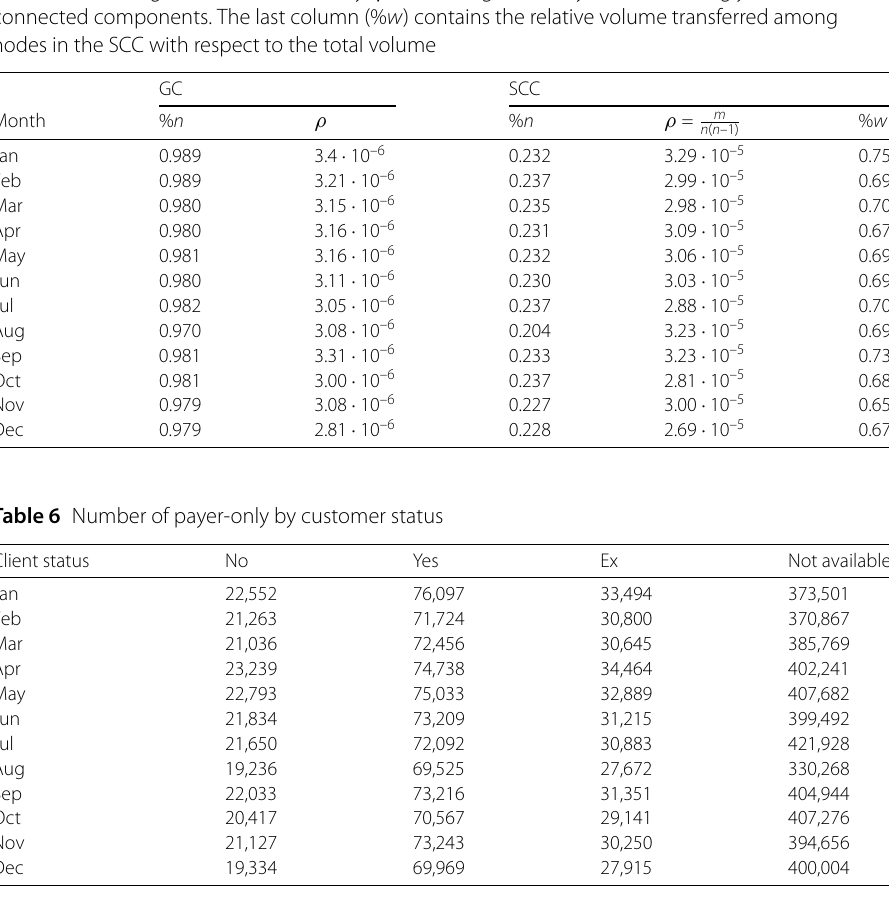
Table 5 Percentage size (% n ) and density ( ρ ) of the largest weakly (GC) and strongly (SCC) connected components. The last column (% w ) contains the relative volume transferred among nodes in the SCC with respect to the total volume GC SCC Month % n ρ % n ρ = m Jan